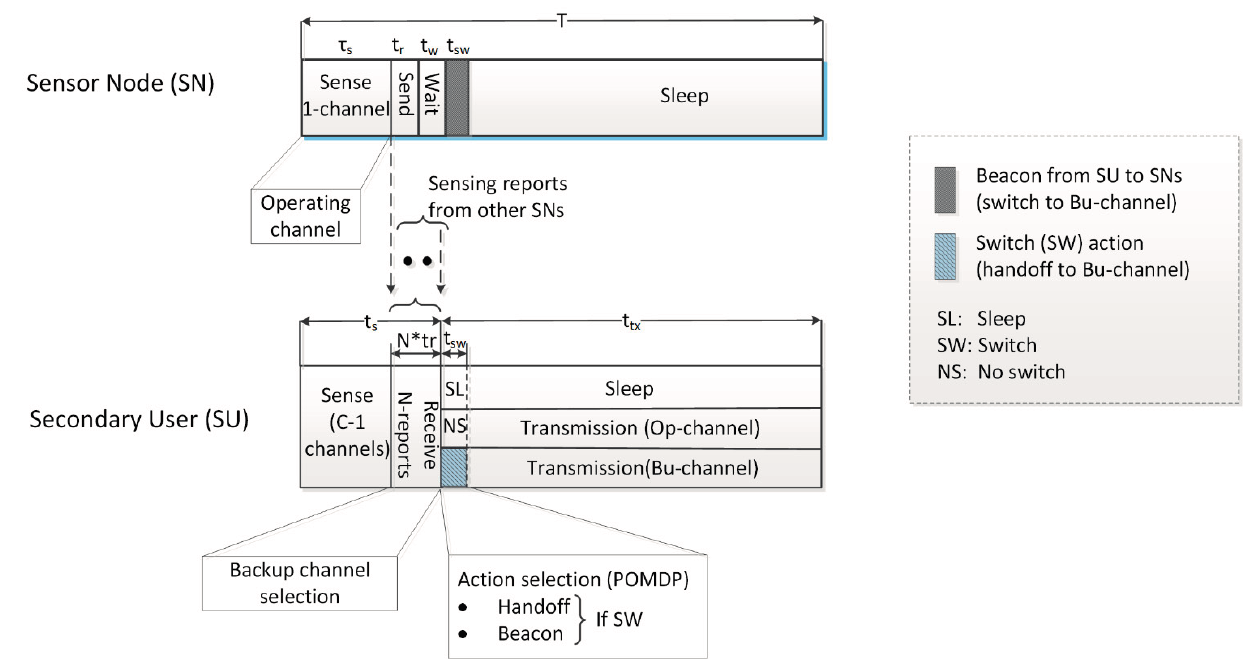
Figure 2. Slot structure of the sensor nodes and secondary